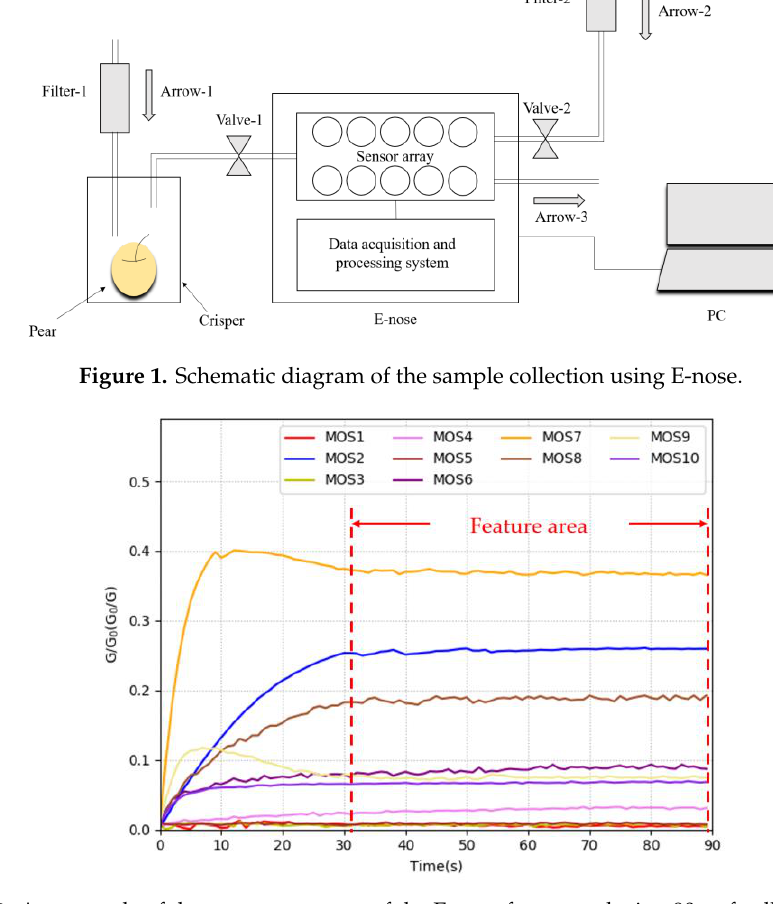
Table 3. Label result and number of samples. Training Samples.